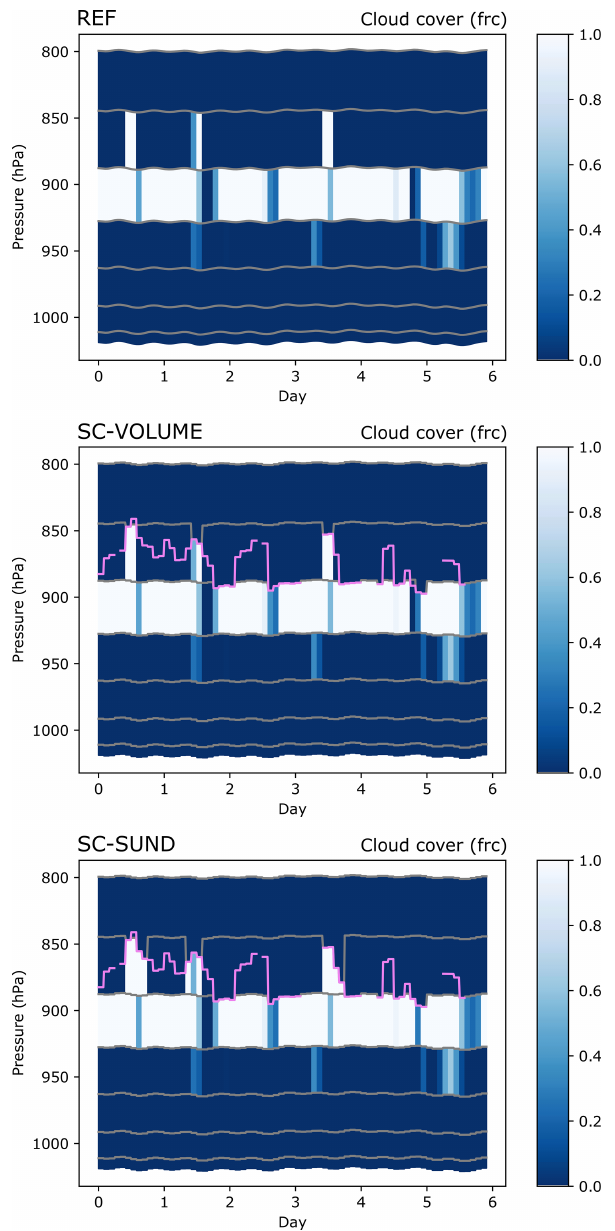
Figure 5. Cloud cover fraction of clouds in the EPIC SCM simula- tions in REF, SC-VOLUME, and SC-SUND. The grey lines repre- sent the model half-levels, and the magenta line is the reconstructed inversion pressure. The inversion’s evolution in time appears more steplike than in Fig. 3 because the refined grid is only applied for the radiation routine at radiation time steps (every